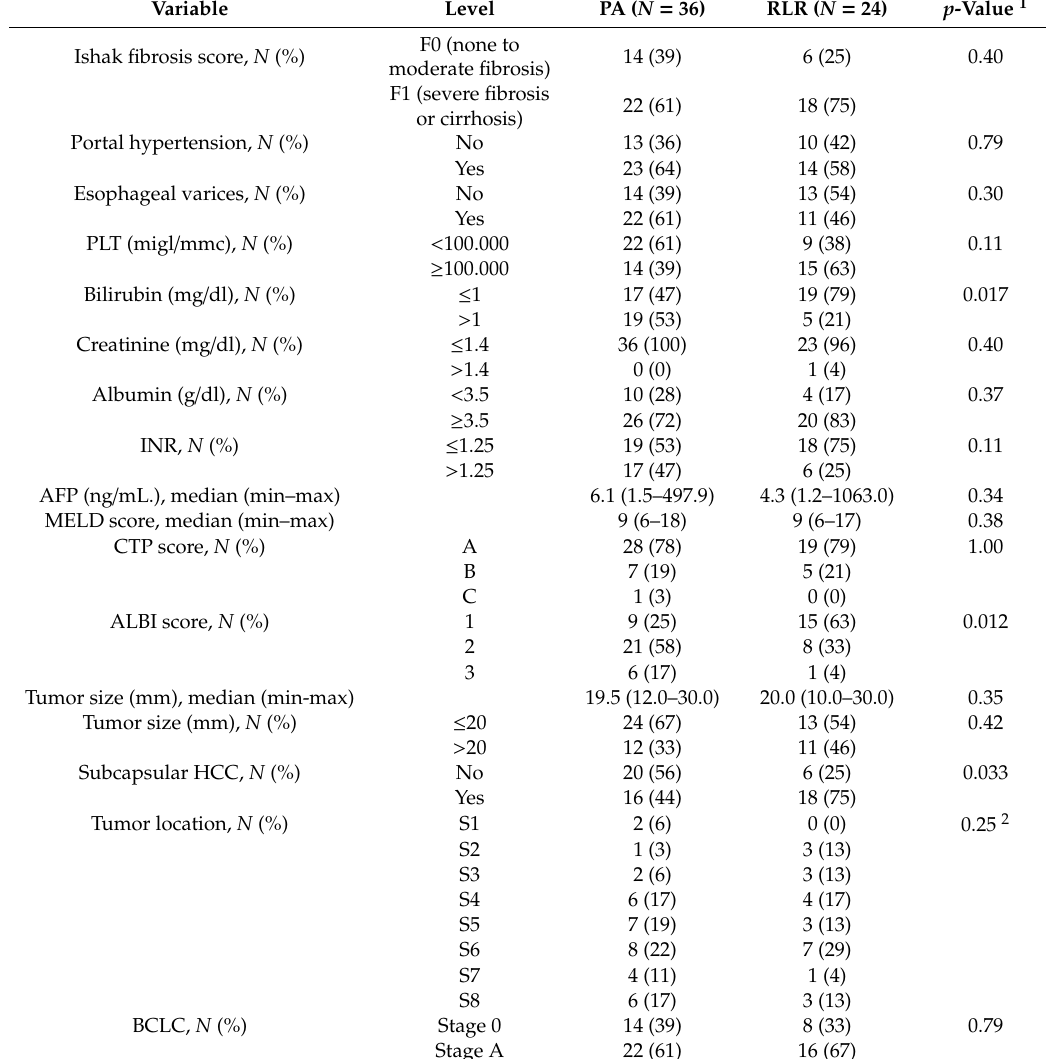
Table 2. Liver function and hepatocellular carcinoma (HCC) characteristics ( N = 60). Variable Level PA ( N =